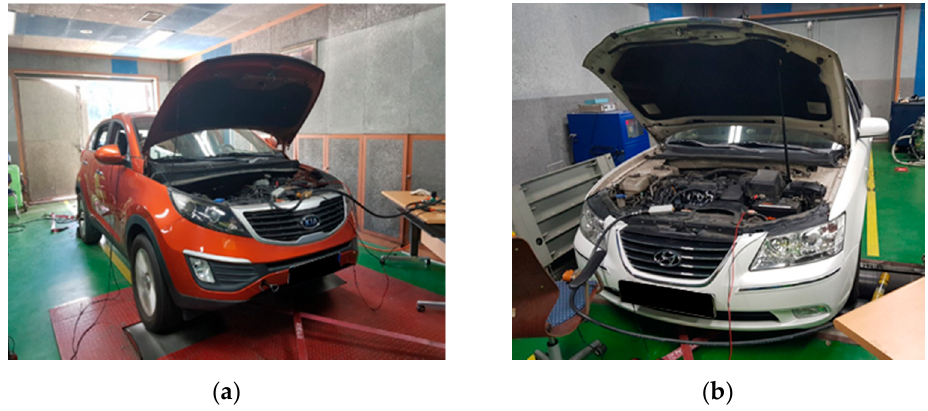
Figure 2. Photographs of experimental setup using 30,000 and 180,000 km mileage cars. ( a ) Vehicle mileage: 30,000 km; ( b ) vehicle mileage: 180,000 km. Table 2. Specifications of gasoline engines.